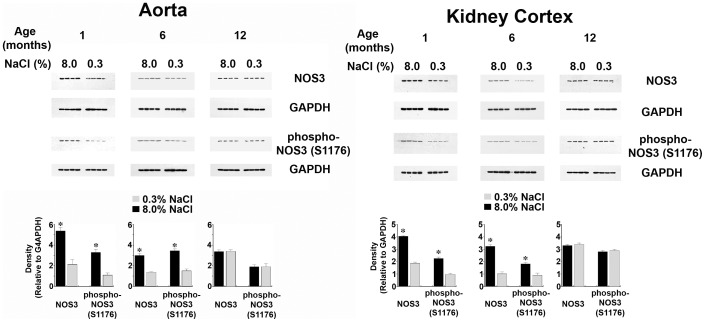
Effect of aging on NOS3 and phospho-NOS3(S1176) levels in aorta and kidney cortex.Tissues from rats age 1 and 6 months, but not tissues from the 12-month old rats, demonstrated an increase in NOS3 and phospho-NOS3(S1176) levels in response to the high-salt diet. n = 4 rats in each group. *p-value<0.05 compared to the corresponding group of rats maintained on 0.3% NaCl diet for 4 days.